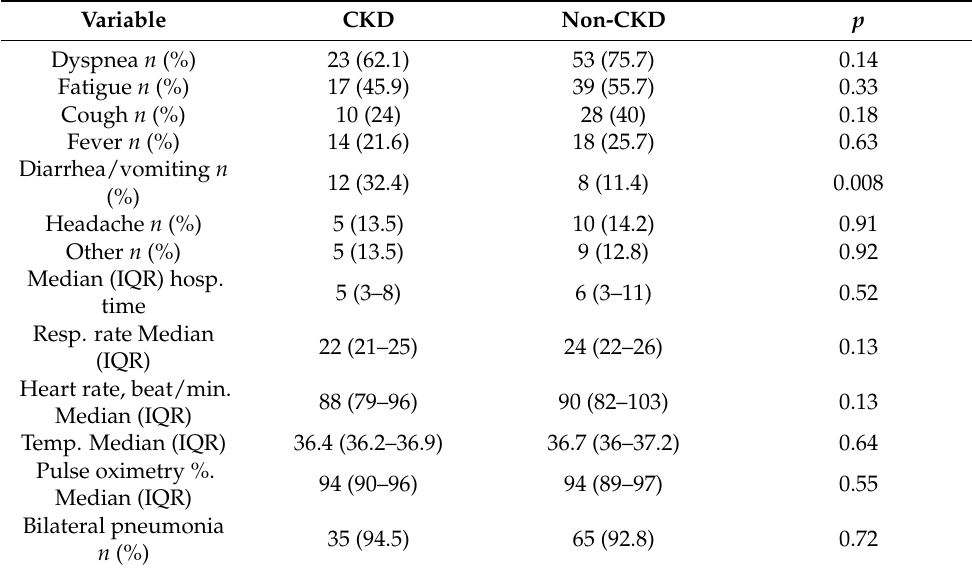
Table 2. Signs, symptoms and main clinical findings at admission.